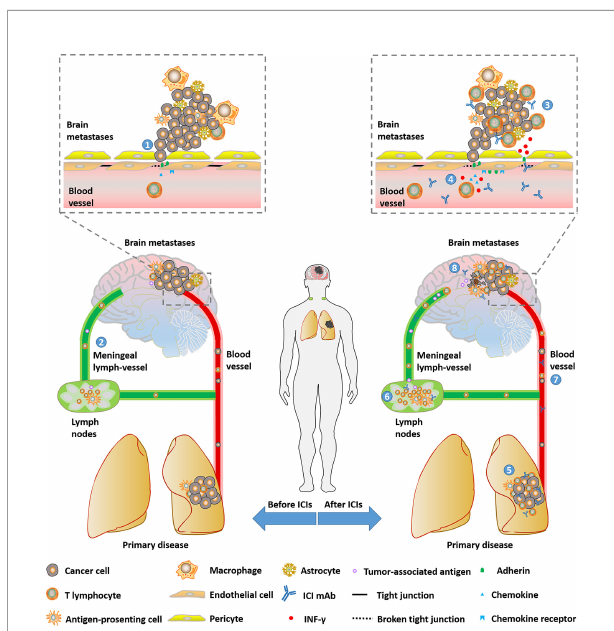
FIGURE 1 | Potential mechanisms that NSCLC patients with brain metastases could bene fi t from ICIs. (1) BBB will be loosened with the progression of